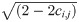
Large network layout of correlation based upon PMFG.From (a) to (f) are PM2.5, PM10, CO, NO2, O3 and SO2 respectively. To construct the network, we use the (2-2ci,j) as a transformed notation for the correlation.